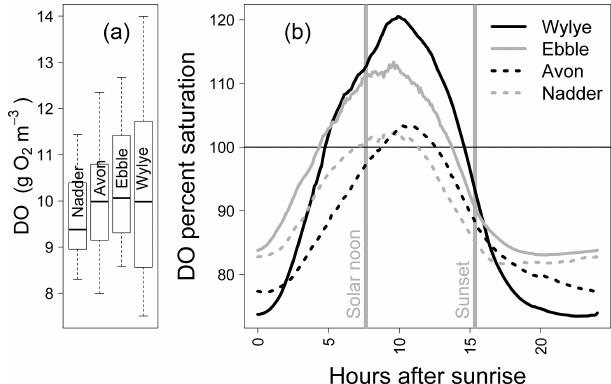
Figure 2. Distributions of DO values (a) and mean DO percent sat- uration by hours after sunrise (b) for 5 to 20 May